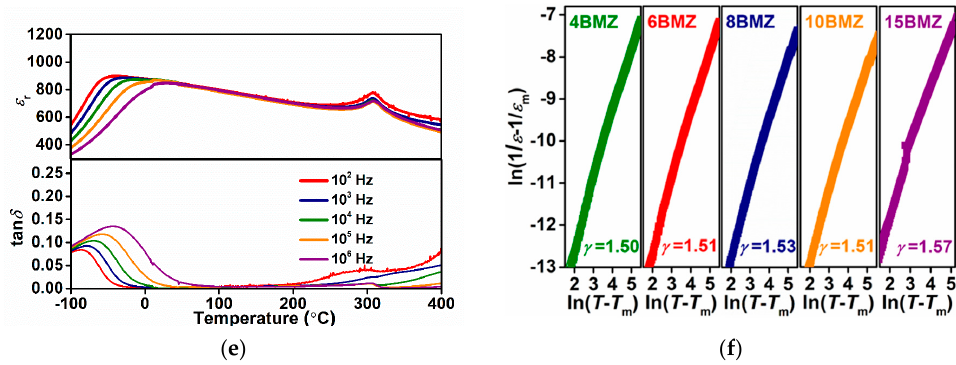
Figure 3. Temperature dependence of ε r and tan δ of (1 − x )(Sr 0.7 Bi 0.2 )TiO 3 - x Bi(Mg 0.5 Zr 0.5 )O 3 ceramics: ( a ) x = 4%; ( b ) x = 6%; ( c ) x = 8%; ( d ) x = 10%; ( e ) x = 15%; ( f ) ln (1/ ε − 1/ ε m ) as a function of ln ( T − T m ) for (1 − x )(Sr 0.7 Bi 0.2 )TiO 3 - x Bi(Mg 0.5 Zr 0.5 )O 3 ceramics at 1 MHz. Table 1. The summary of dielectric performance at 1 kHz and energy storage properties at 200 kV/cm for (1 − x )(Sr 0.7 Bi 0.2 )TiO 3 - x Bi(Mg 0.5 Zr 0.5 )O 3 ceramics.